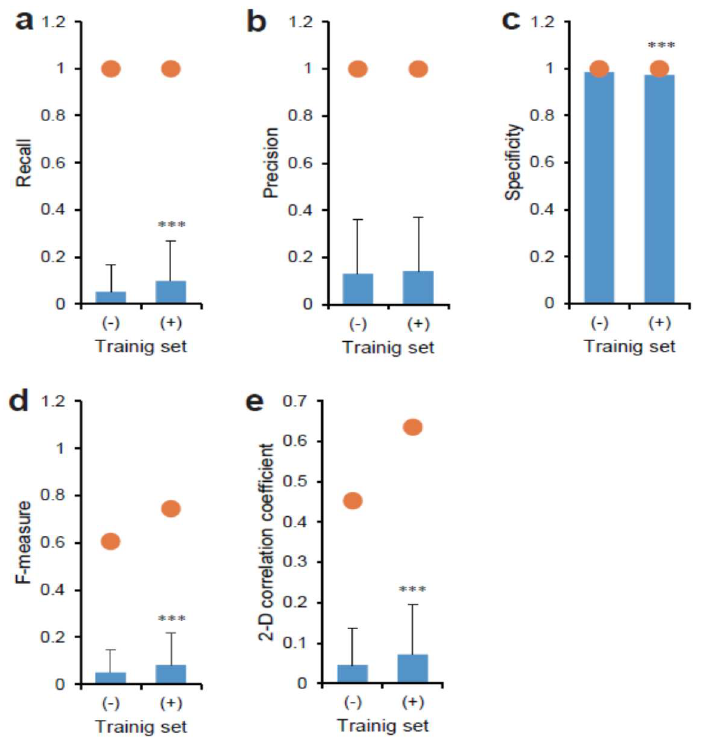
Figure 5. Comparison between depicted CSC image in tissue by AI models and original GFP fluorescence. Images of Hoechst 33342 overlaid-phase contrast ( + ) or not overlaid-phase contrast (-) were used for training AI for AI models. The AI output images and each true target image were compared using the values of ( a ) recall, ( b ) precision, ( c ) specificity, ( d ) F-measure, and ( e ) image correlation coefficient. Closed circles indicate maximum values. Mean ± S.D., n = 684. *** p < 0.01.